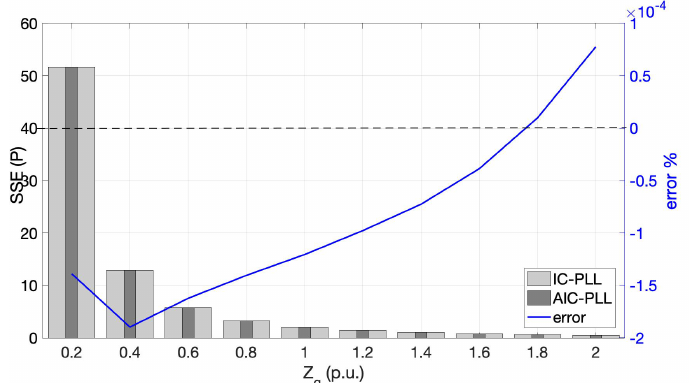
Figure 14. SSE for the active power tracking for the IC-PLL- and AIC-PLL-based system for half value of the maximum power (inverter